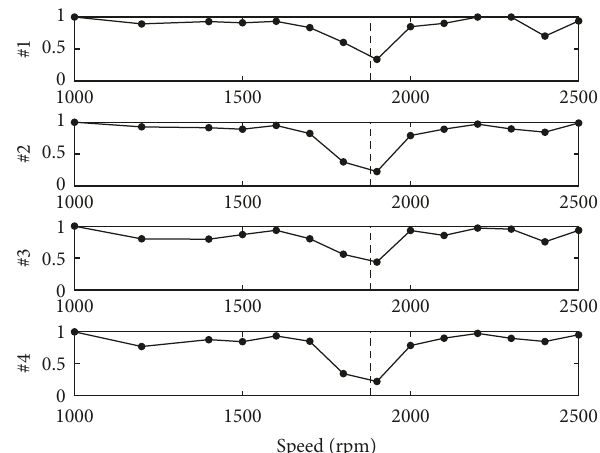
Figure 5: The useful information ratio curve of measuring planes A and B. #1–#4 correspond to the four measuring